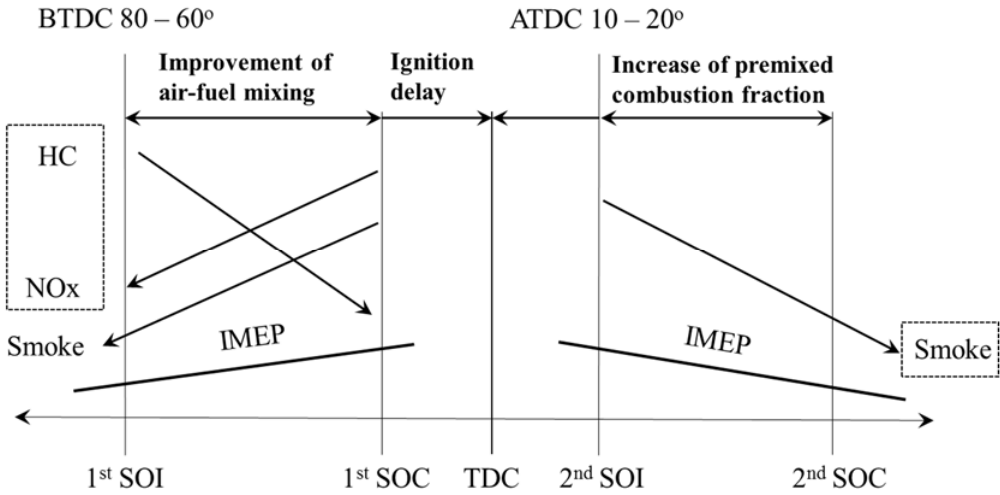
Figure 3. Effect of injection timing of multiple injection method (SOI: Start of Injection, SOC: Start of Combustion).